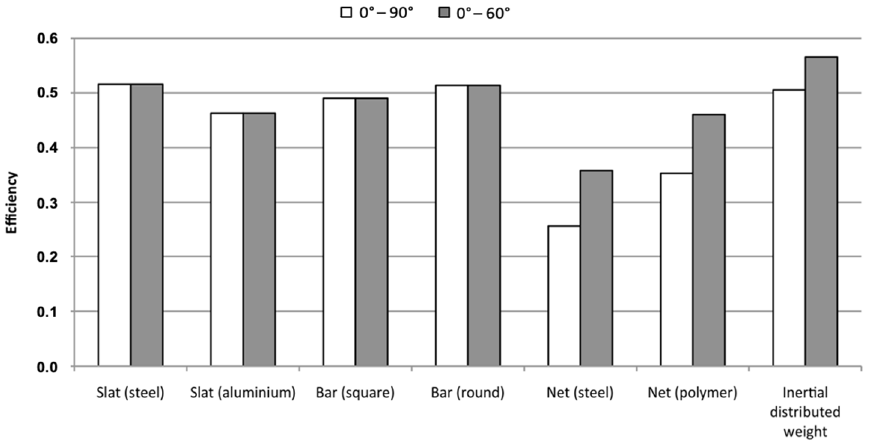
Figure 29. Average efficiency of the different considered cage armour systems for a maximum vertical impact angle of 15° as a function of the considered horizontal impact angle range.